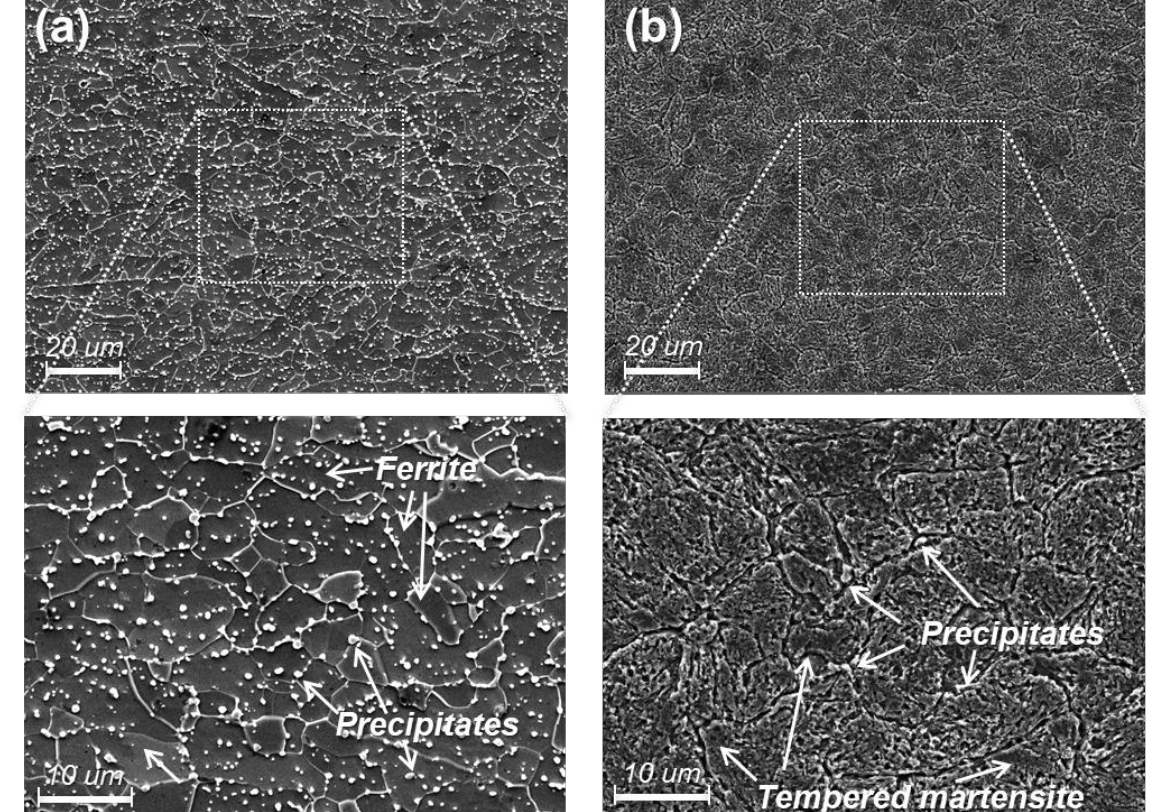
Figure 13. SEM images for the comparison of microstructures of ( a ) N-H13 and ( b ) HT-H13.